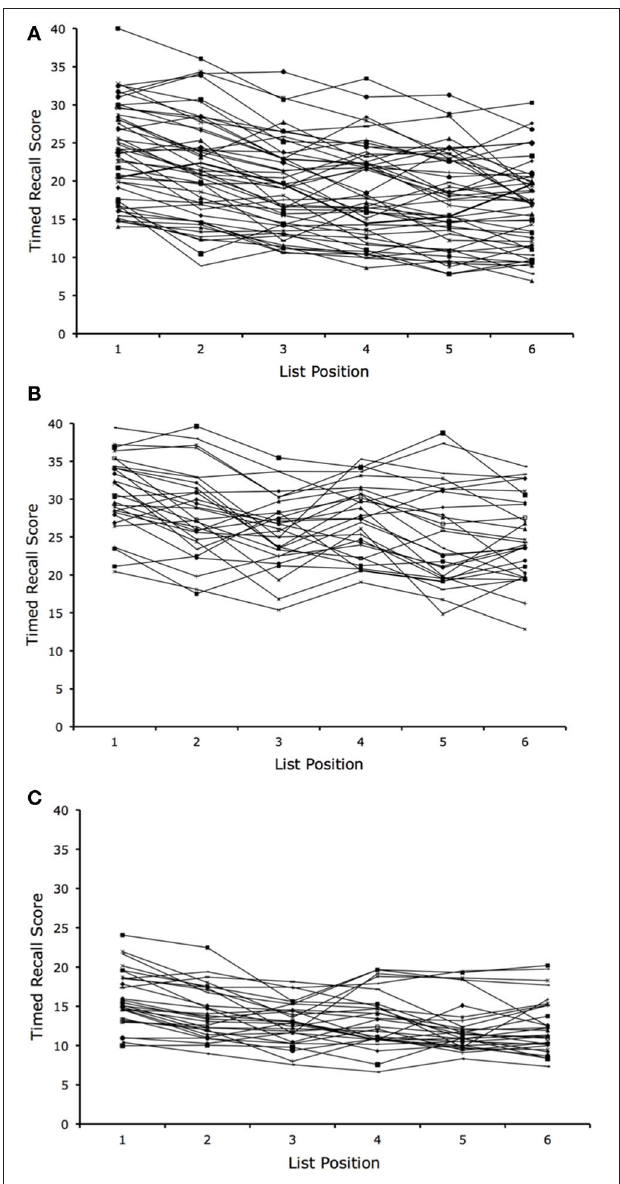
FIGURE 3 | Timed Recall Scores averaged over sessions by list position within a session for each individual in the group of children (A), younger adults (B), and older adults (C). Each line represents the scores for one individual.